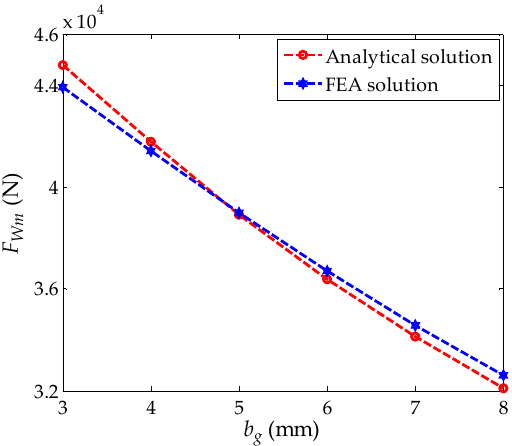
Figure 11. The peak braking force varying with the induction plate thickness.